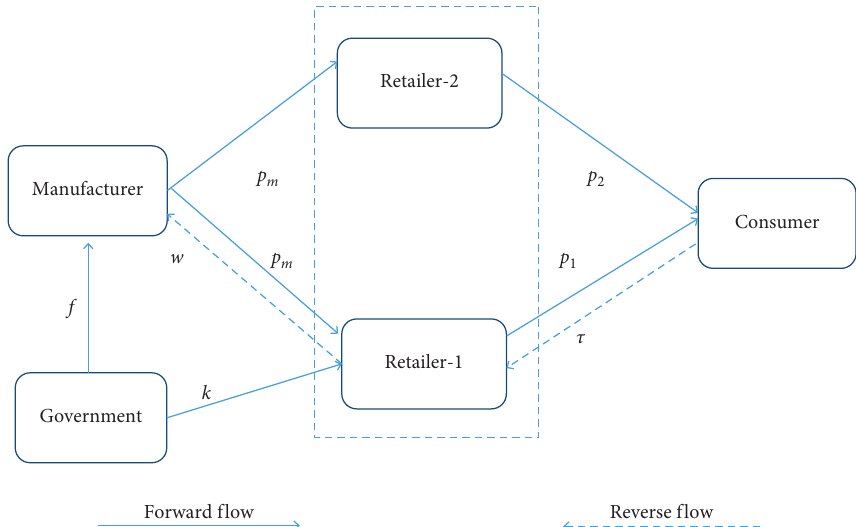
Figure 3: CLSC structure with two competing retailers with carbon emission RPM and recovery rate